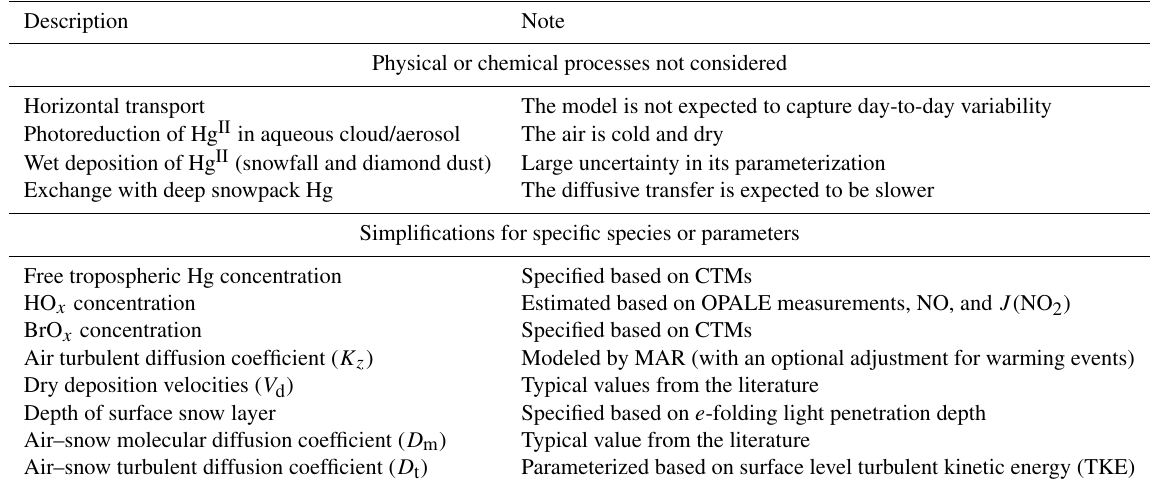
Table 1. Major assumptions and simplifications made in the mercury model. Description